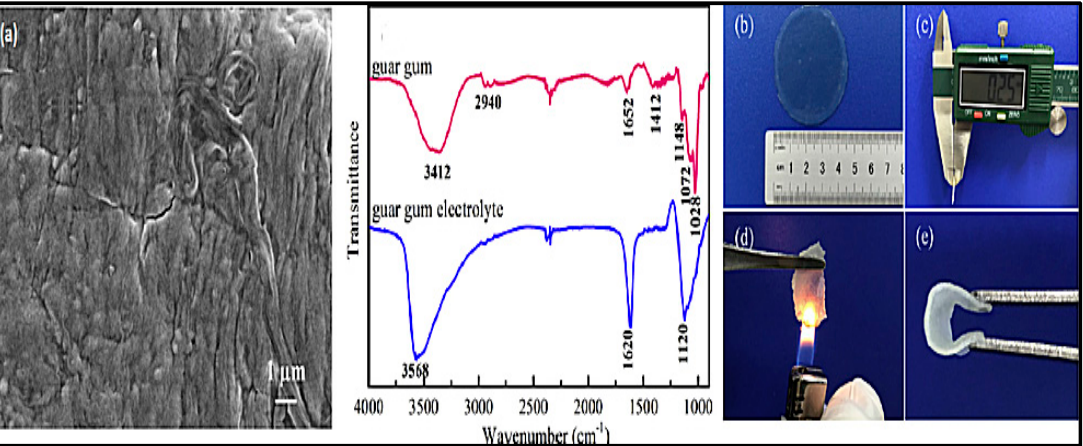
Figure 22. ( a ) SEM image of the guar gum electrolyte and FTIR spectra of guar gum and guar gum electrolyte. ( b ) Photograph of the guar gum electrolyte. ( c ) 0.25 mm thick guar gum electrolyte with 2M ZnSO 4 and 0.1M MnSO 4 . ( d ) Flammability tests on the guar gum electrolyte. ( e ) Photograph of a